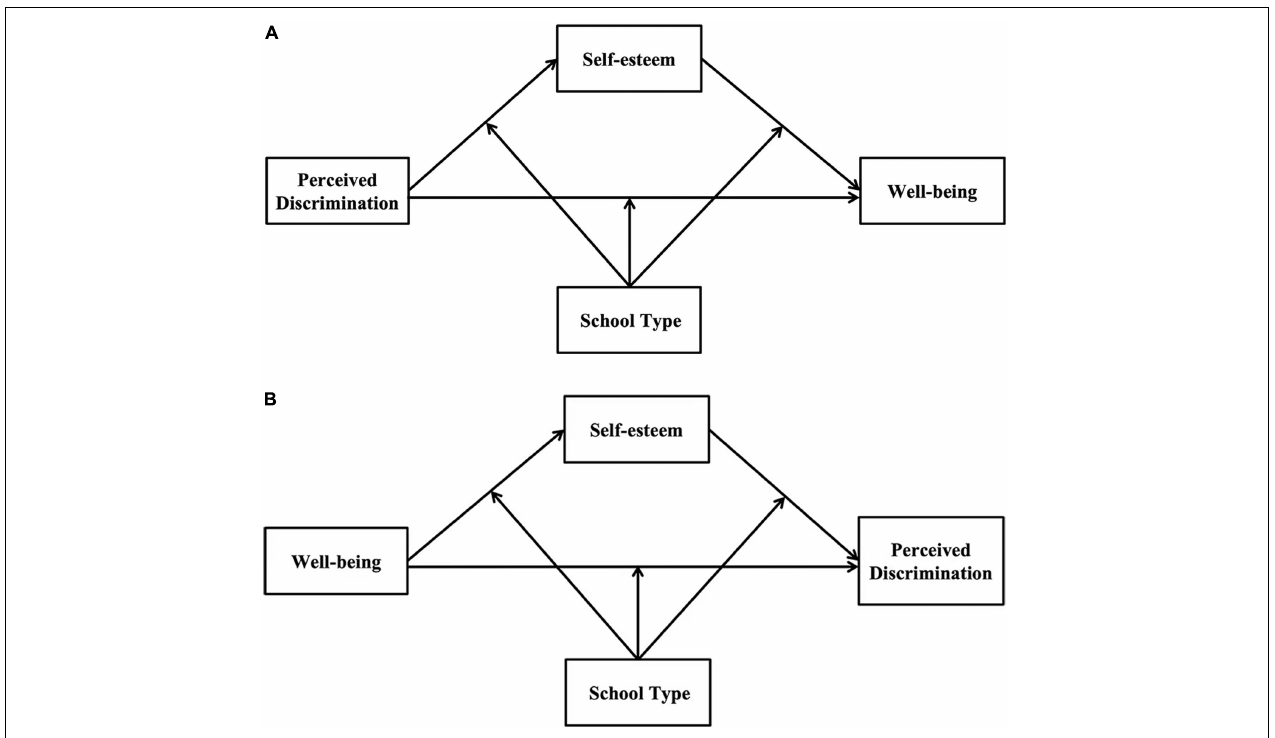
FIGURE 1 | The proposed moderated mediation model. (A) The moderated mediation model of perceived discrimination to well-being; (B) the moderated mediation model of well-being to perceived